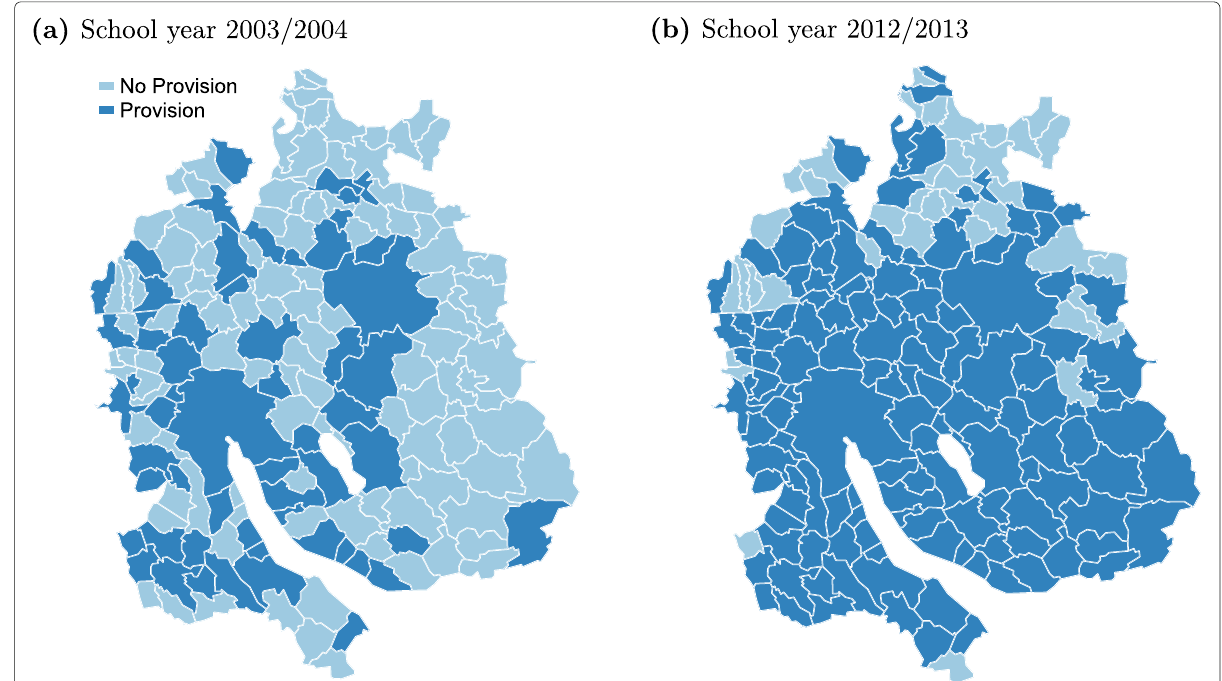
Fig. 3 Prevalence of lunchtime and after-school care in the canton of Zurich before and after the introduction of the new regulation. Light blue areas show municipalities which do not offer lunchtime or after-school care in the given period, whereas dark blue areas show municipalities with lunchtime and after-school care in the given period